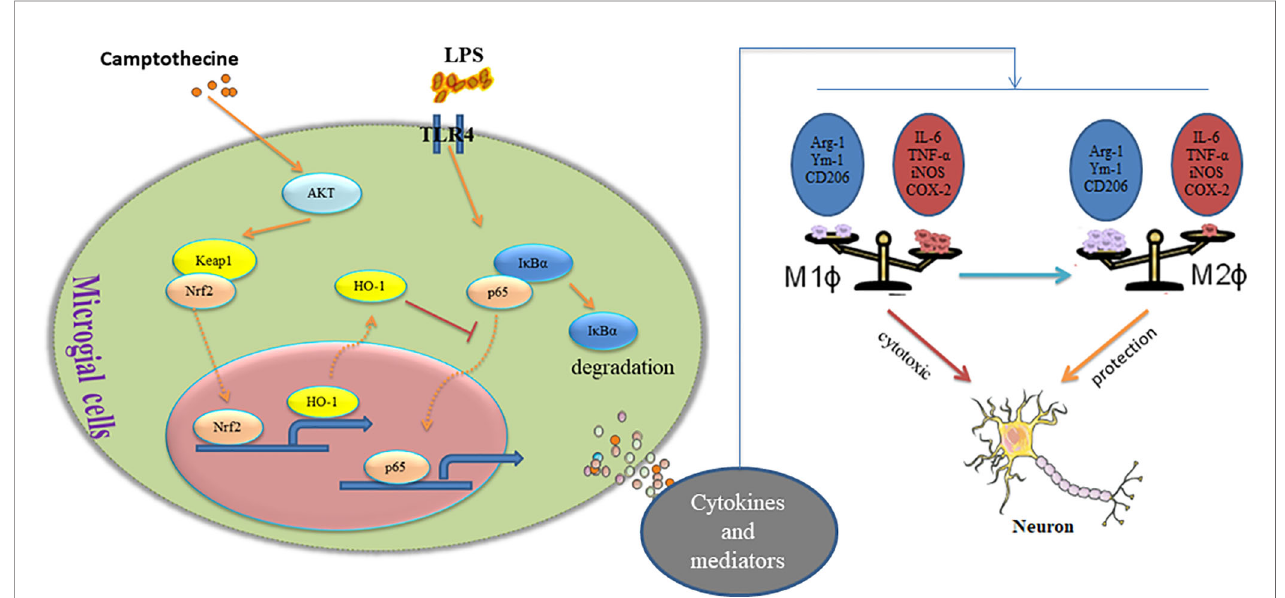
FIGURE 9 | Camptothecin regulates microglia polarization and exerts neuroprotective effects via the AKT/Nrf2/HO-1-NF- k B signal